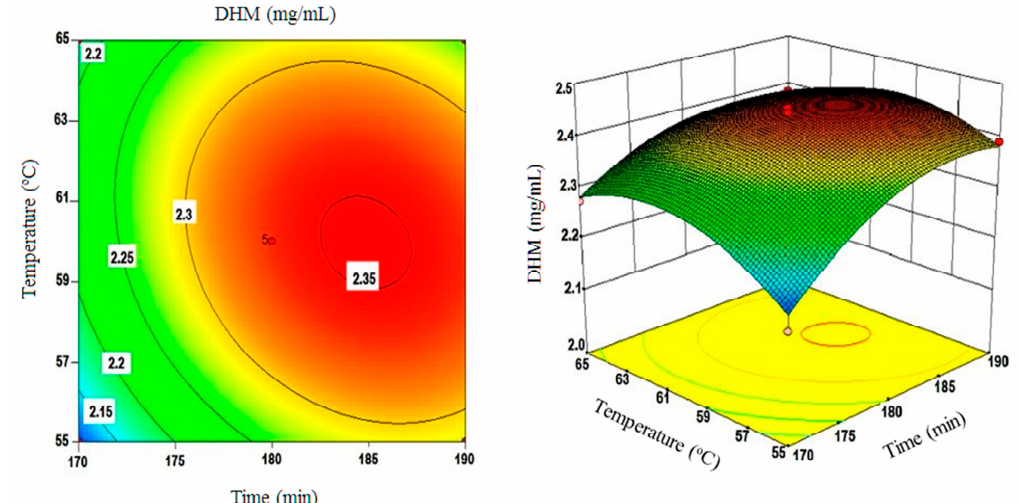
Figure 4. A three dimensional (3D) surface plot depicting the effect of extraction time(s) and extraction temperature(s) interactions on the yields of DHM (mg/mL). Molecules 2017, 22, 2250